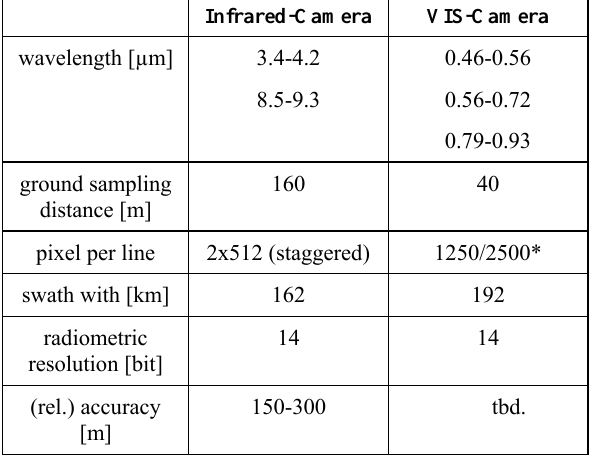
Table 1: TET-1 / BIROS camera parameter Land surface physical variables to be derived from FireBird